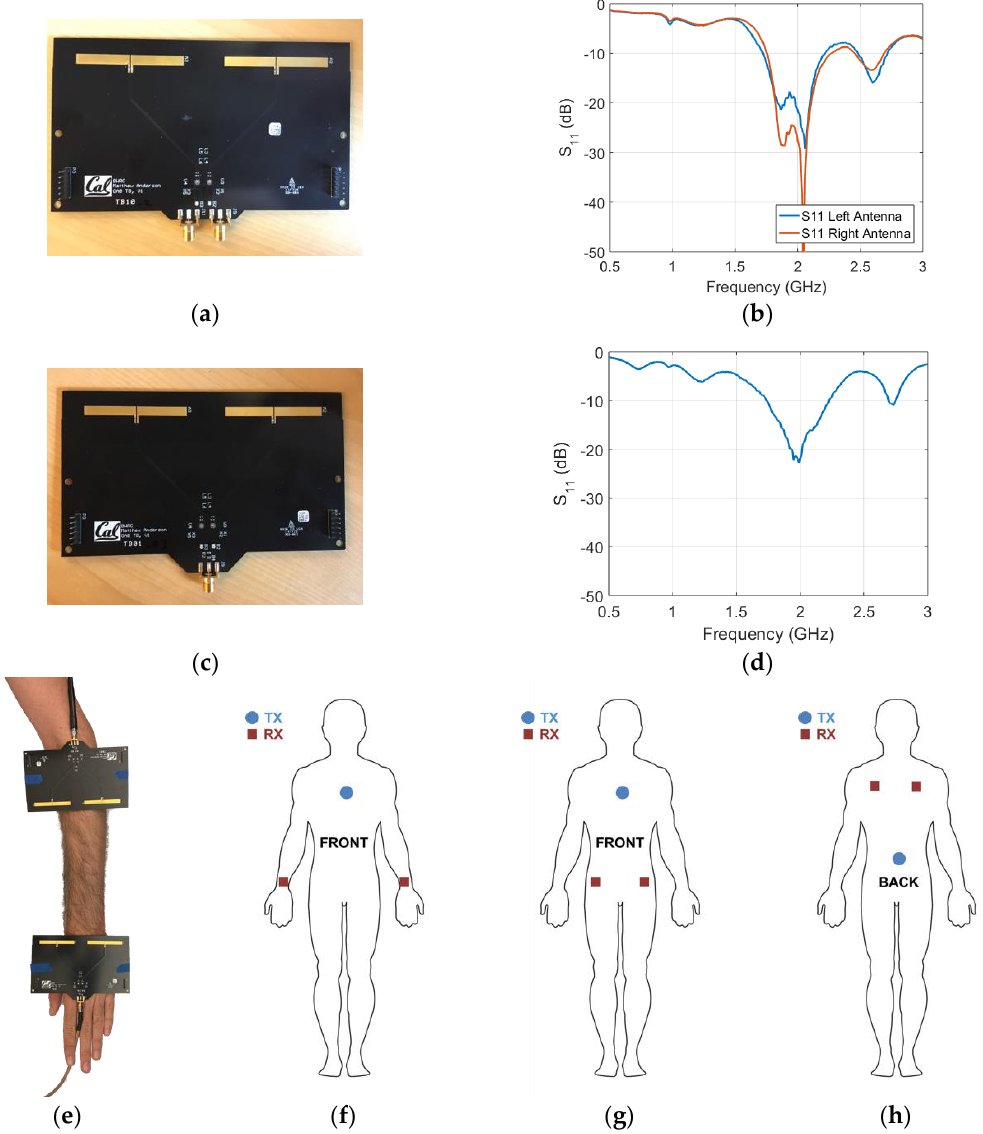
Figure 8. ( a ) Phased two-port antenna array used for measurements at 2.05 GHz. ( b ) Power reflection coefficient of both dipole antennas in the array. ( c ) Power-combined antenna array used for measurements at 2.05 GHz. ( d ) Power reflection coefficient of the power-combined antenna array. ( e ) Array placement on the body. The shown boards are the power-combined arrays. ( f ) On-body beam steering scenario 1 ( g ) On-body beam steering scenario 2 ( h ) On-body beam steering scenario 3.